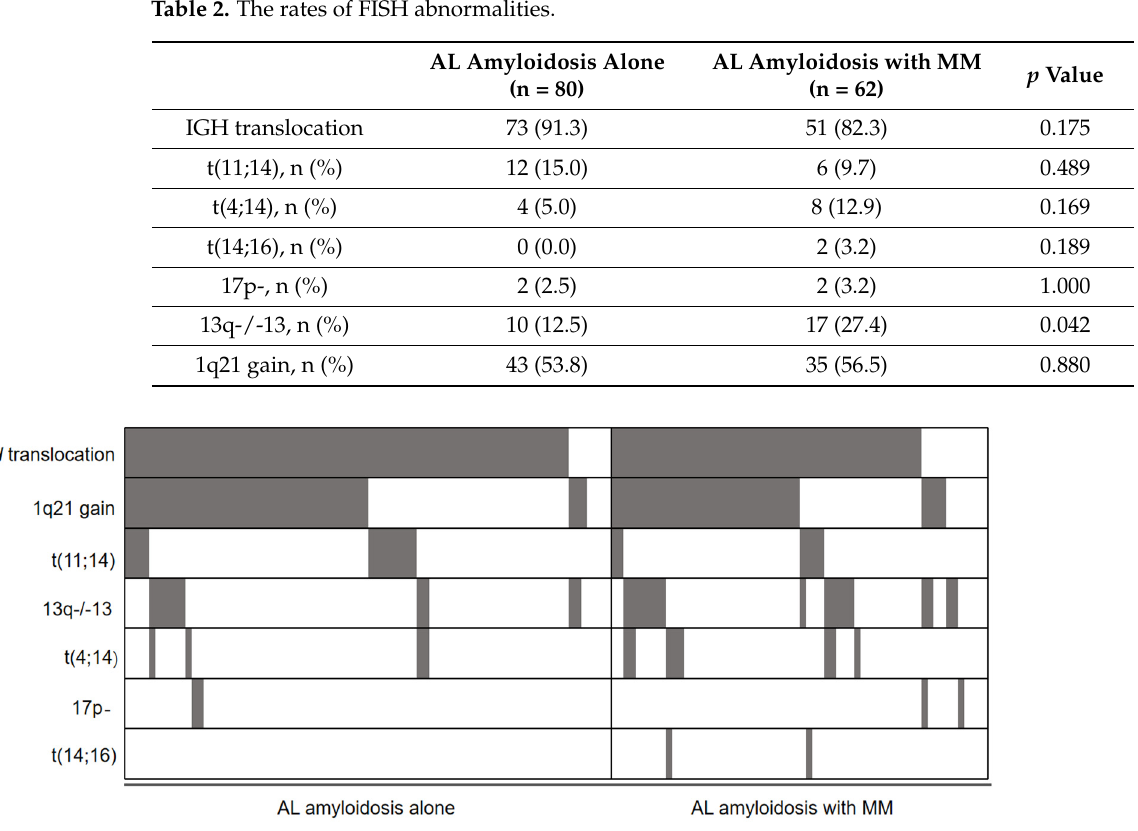
Table 2. The rates of FISH abnormalities.